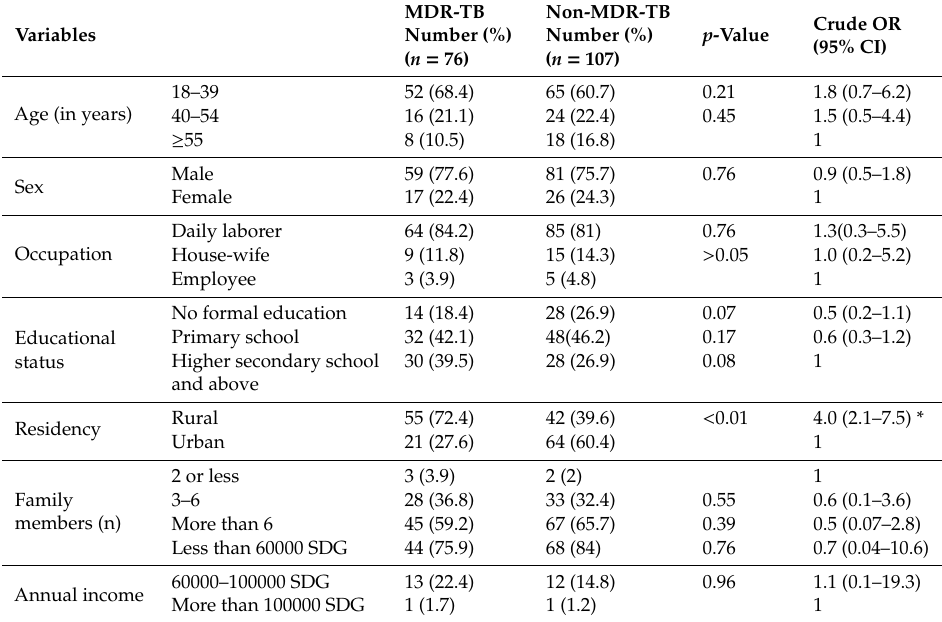
Table3. Association ofsocio-demographic factorswith MDR-TBamong the presumptive MDR-TBcases.